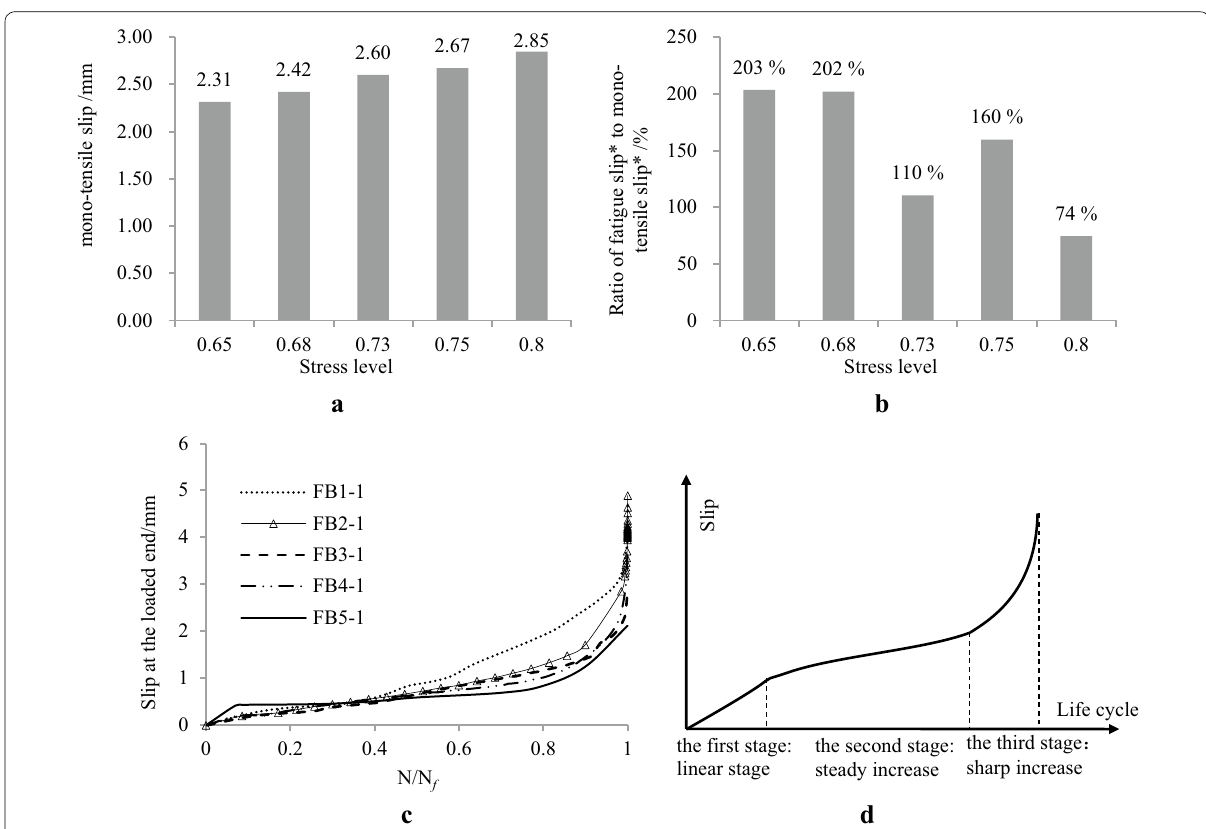
Fig. 15 The slip under cyclic load of round ribbed bar with rib spacing of 12 mm, width of 2.5 mm and height of 1.08